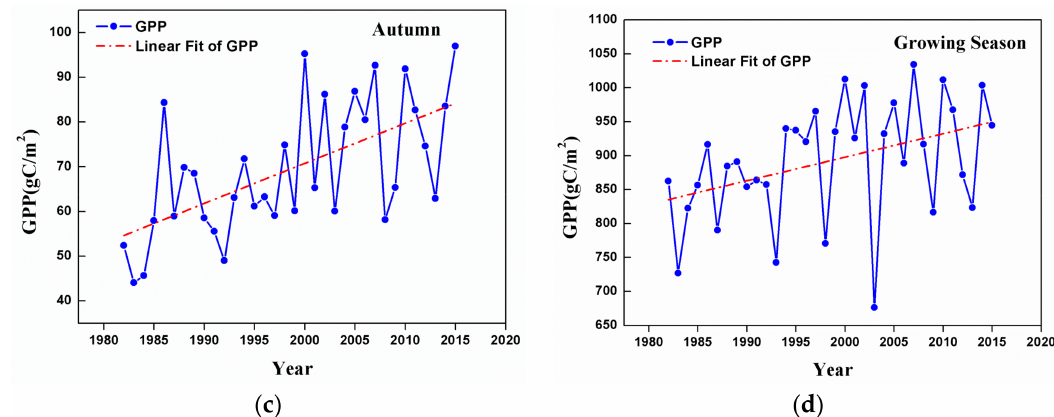
Figure 4. Interannual variation trends of AG in the GKM from 1982 to 2015.